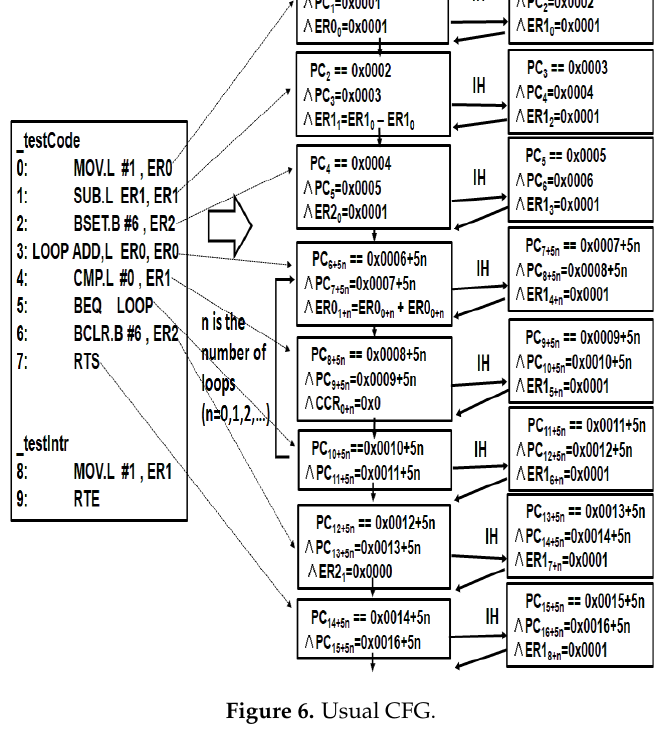
Figure 6. Usual CFG.